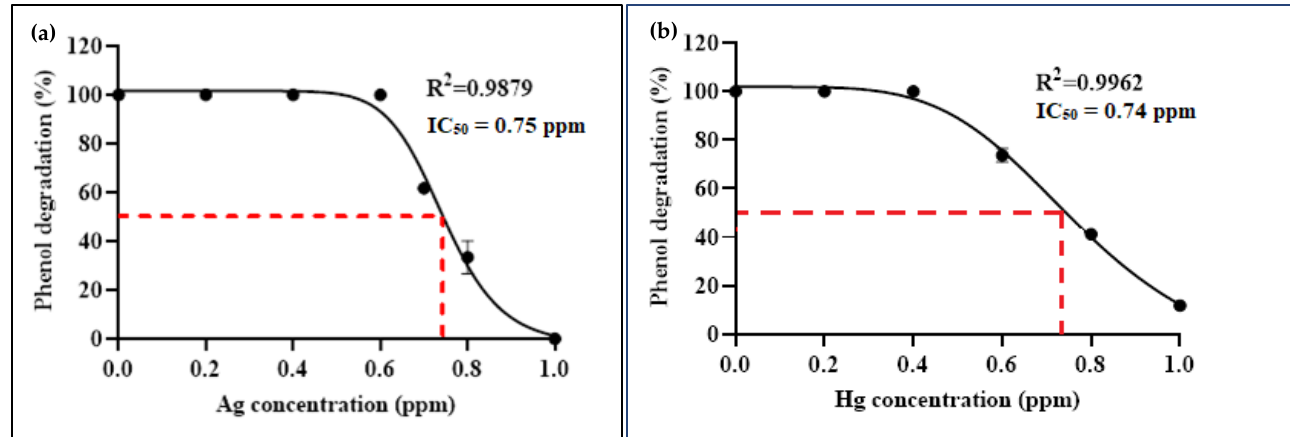
Figure 6. Dose-response curves identifying IC 50 values for Arthrobacter sp. strain AQ5-06 phenol degradation after 120-h exposure to different concentrations of ( a ) Ag and ( b ) Hg.